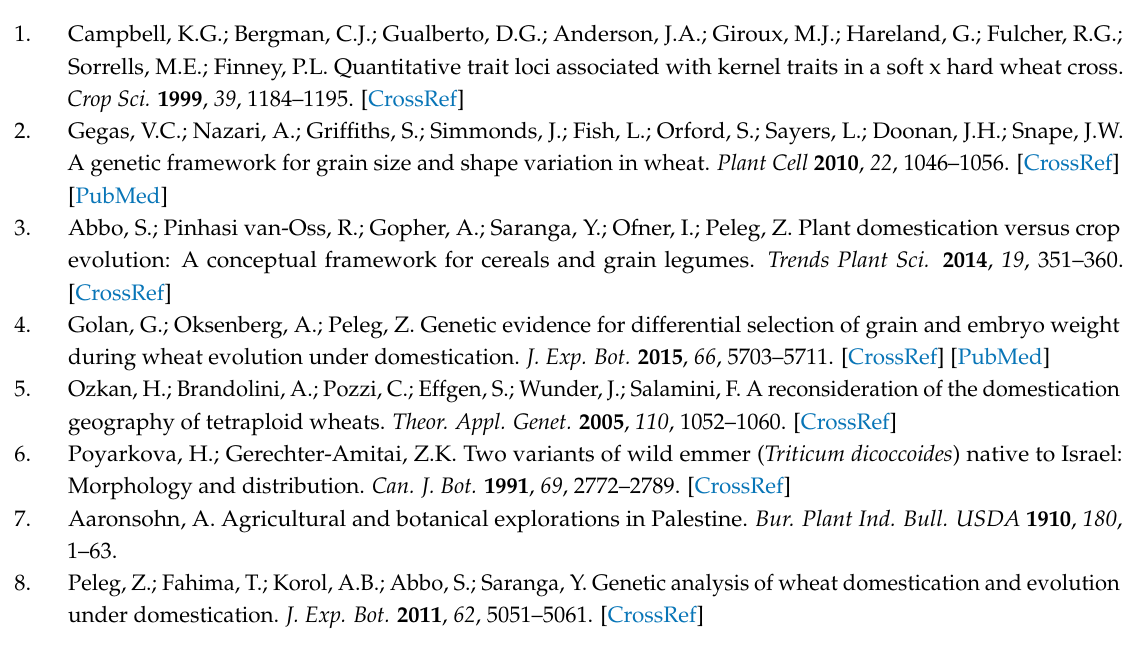
Figure S1: Distributions of thousand-kernel weight (TKW) on the Svevo × Zavitan population across four environments„ Figure S2: QTL analysis for TKW across four experiments, Table S1: QTL parameters for TKW in four environments, Table S2: Significance of 6A TKW QTL between Svevo and Zavitan alleles in the RIL population, Table S3: Mean TKW of parental lines and segregating populations in the 9 independent studies used for the meta-QTL analysis, Table S4: Genotypes used for allelic diversity study with molecular marker for the presence of GRF4-Az and GRF4-Ag